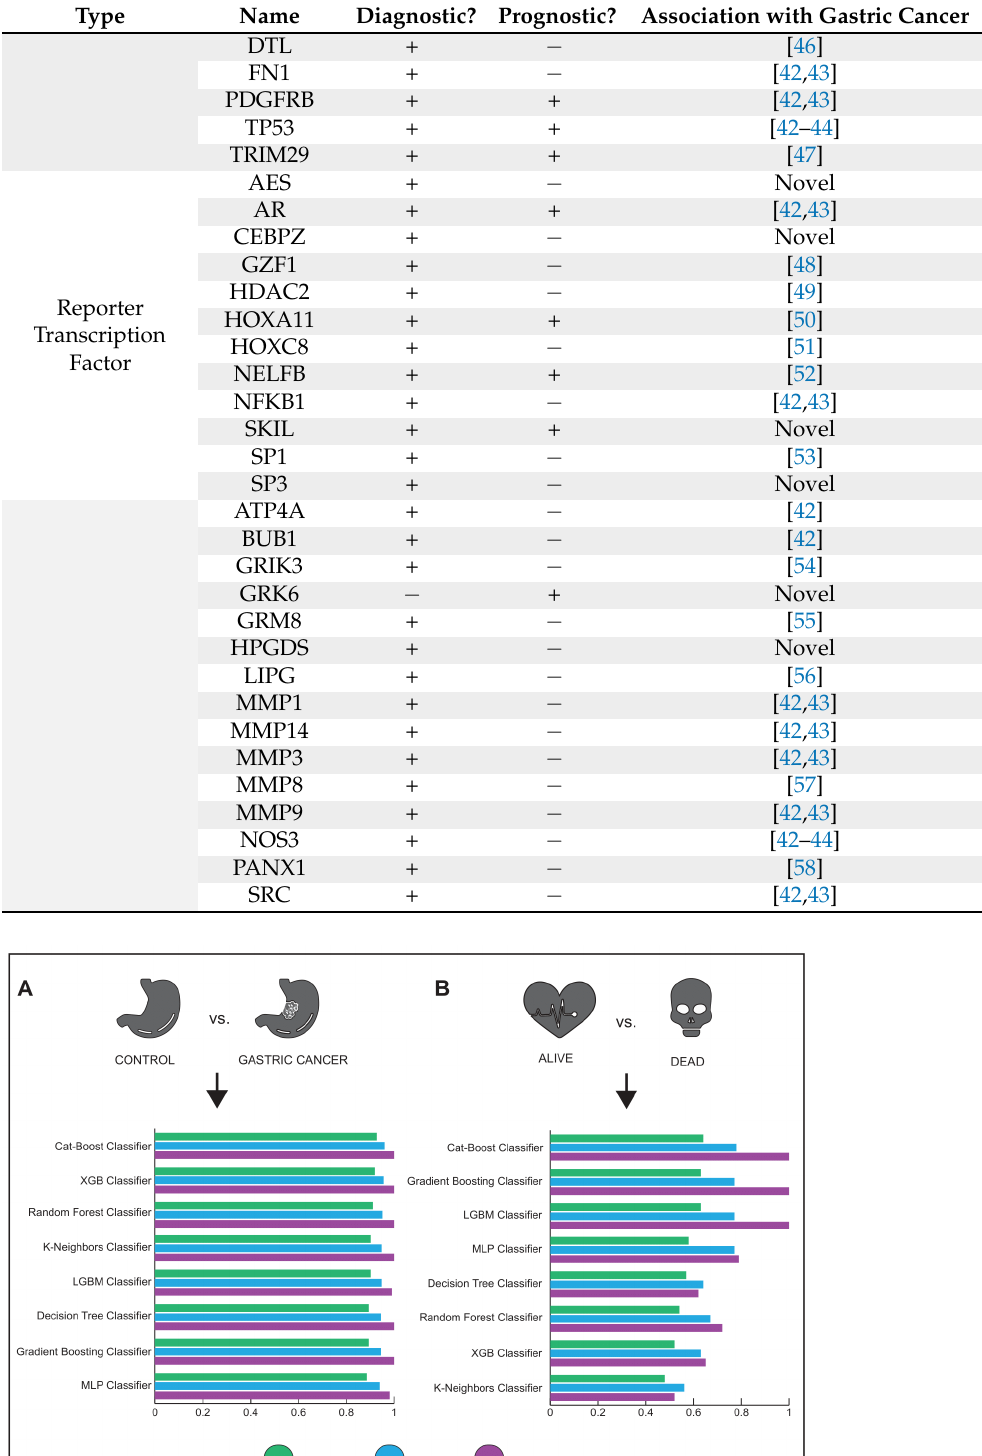
Table 1. The association of diagnostic and prognostic candidate biomarkers with gastric cancer.